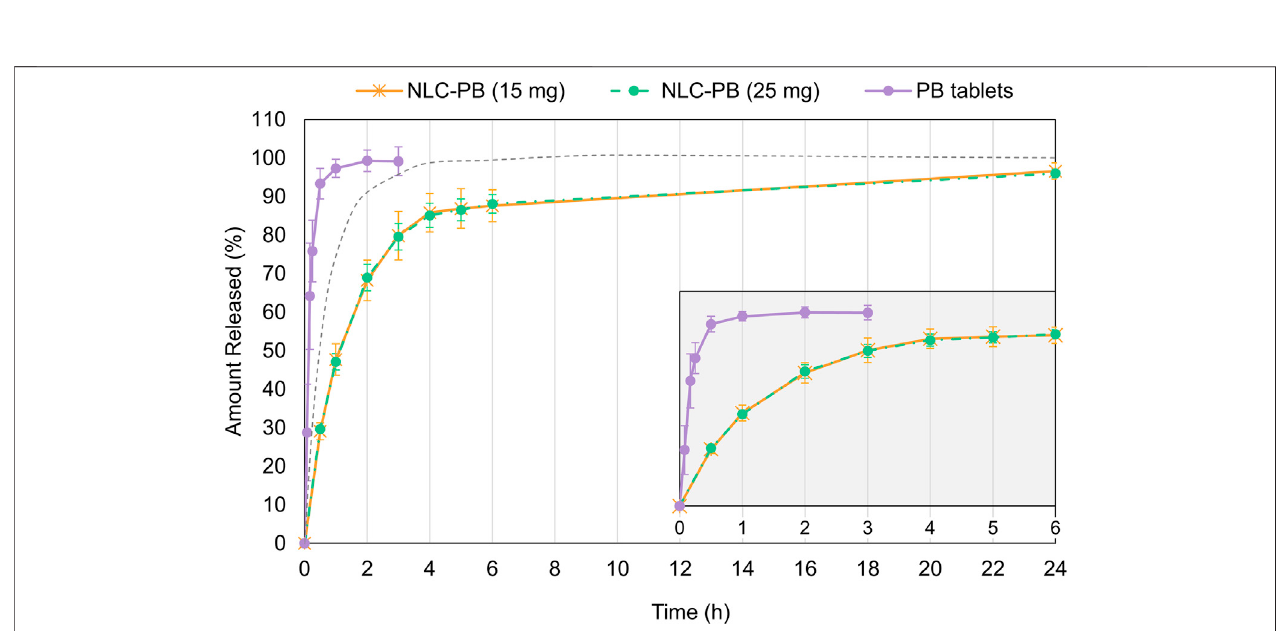
FIGURE8| Release pro fi les ofPBfrom NLC withdifferentdrug loading. Twocontrolswere included: immediate-release PBtablets (Bayer Luminal ® , 100 mg) and a solution of PB inside the dialysis bag (discontinuous grey line). The inserted graph corresponds to the time range from 0 to 6 h. Initial point ( t = 0) was included for graphical purposes.